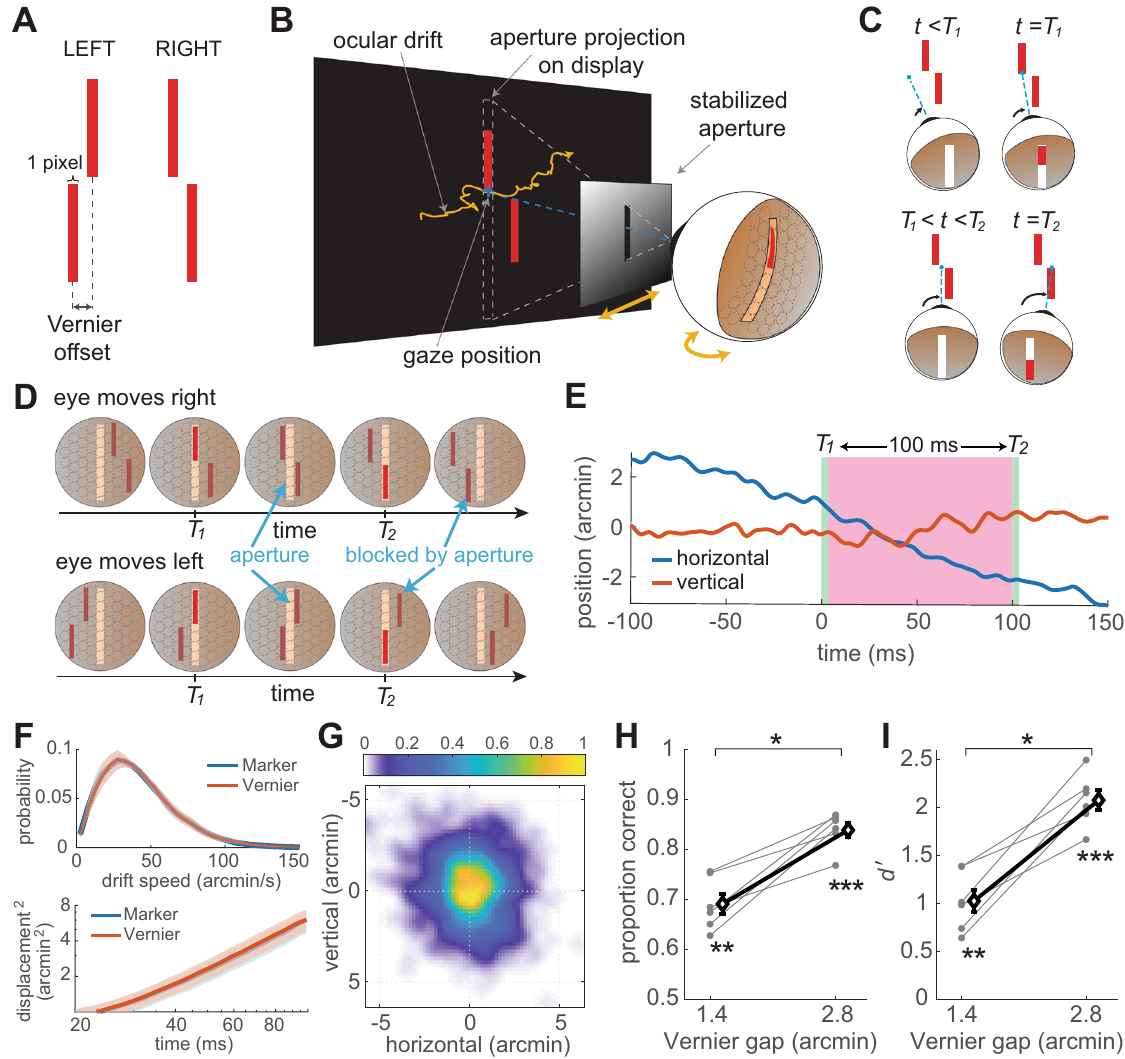
Fig. 1 | Estimating spatial relations via eye movements. A – C Experimental design. A Subjects reported the spatial con fi guration of a Vernier (left or right) viewedthrougharetinally-stabilizedaperture. B Theaperturemovedtogetherwith the eye, to allow stimulationofonly a thin vertical strip on the retina. The width of the aperture was equal to that of each bar in the Vernier (28 0 long; 1.4 0 , the angle covered by one pixel on the CRT). C In this way, each Vernier bar was visible only when it directly overlapped with the aperture, resulting in vertically-aligned bar exposures on the retina. D Motor knowledge of eye movements is required to accomplish this task. The same visual input signals can be obtained with different con fi gurations of the stimulus, when the eye drifts in opposite directions. E Example trace of eye movements in a trial. The shaded green regions mark the periods of exposure of each Vernier bars. The pink region indicates the inter-